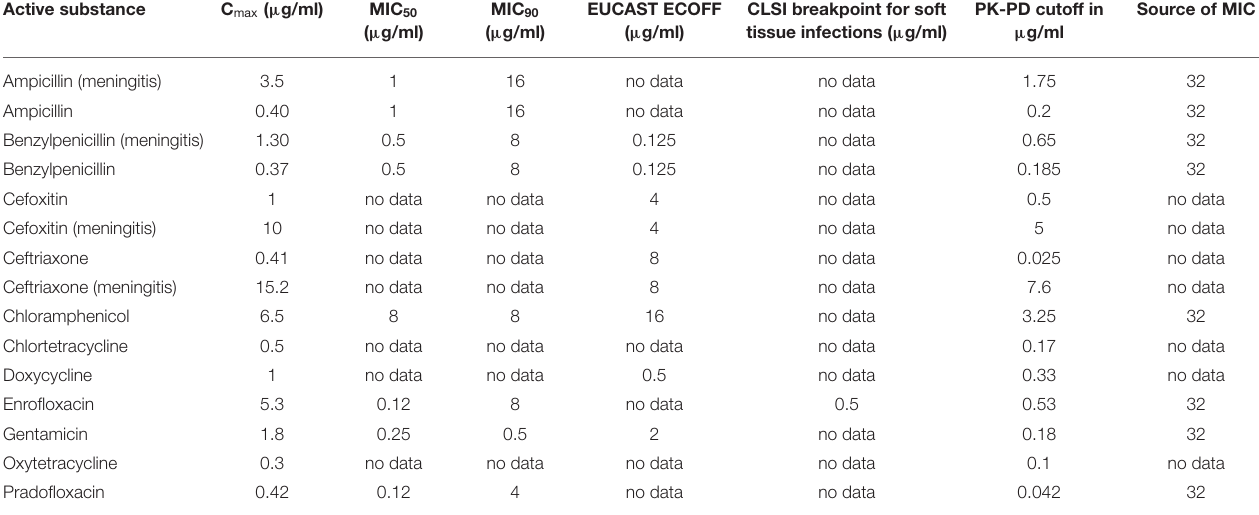
TABLE 9 | C max in CSF in dogs after the administration of various antibiotics in healthy dogs or during meningitis (ampicillin, benzylpenicillin) and selected PK-PD cutoffs of Staphylococcus aureus . Active